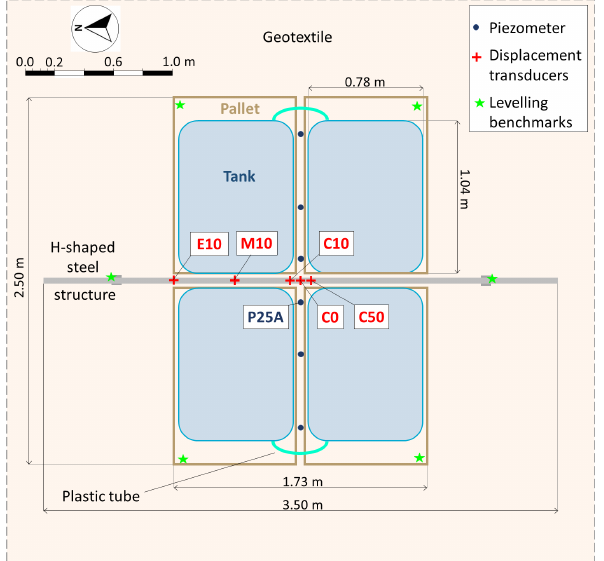
Figure 6. Sketch of the loading with dimensions and location of the monitoring instruments.